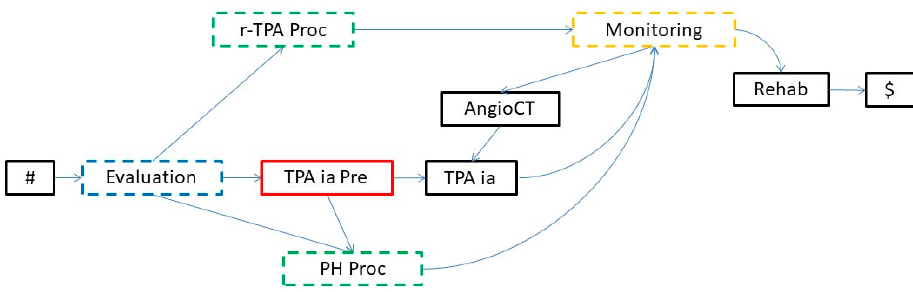
Figure 14. Process model in Figure 13 resulting from merging the Monitoring activities.